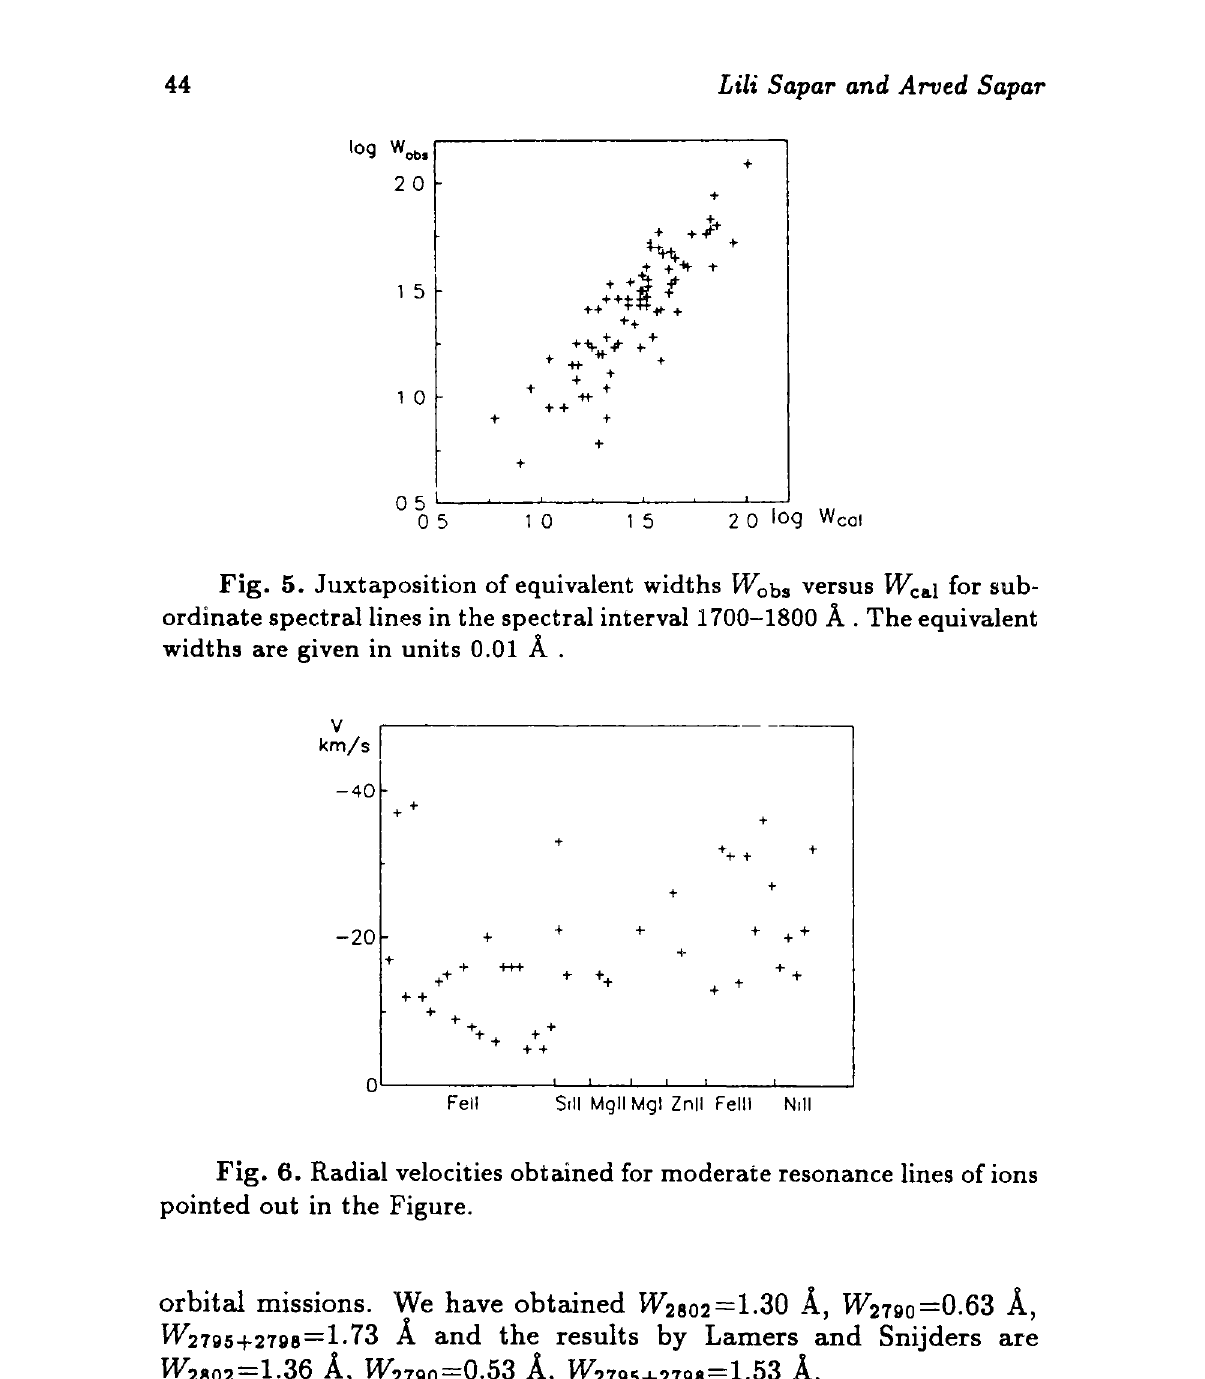
Fig. 6. Radial velocities obtained for moderate resonance lines of ions pointed out in the